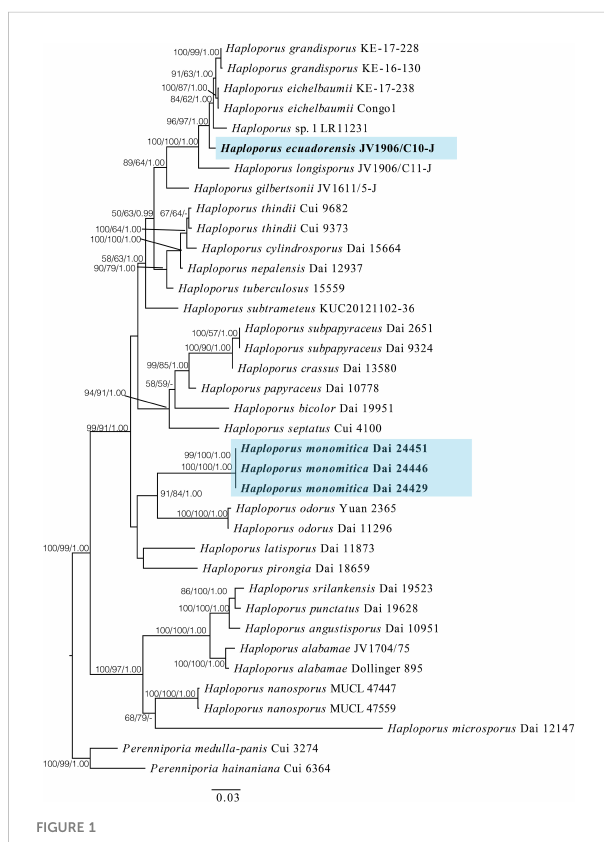
FIGURE 1 A maximum likelihood phylogenetic tree of Haploporus based on ITS, LSU, and mtSSU sequences, with two specimens of Perenniporia hainaniana and P. medulla-panis used as outgroups. The new species Haploporus ecuadorensis and H. monomitica are shaded. Maximum likelihood bootstrap values ( ≥ 50%)/maximum parsimony bootstrap values ( ≥ 50%)/Bayesian posterior probabilities ( ≥ 0.95) of each clade are indicated along branches. A scale bar below indicates the number of substitutions per site.